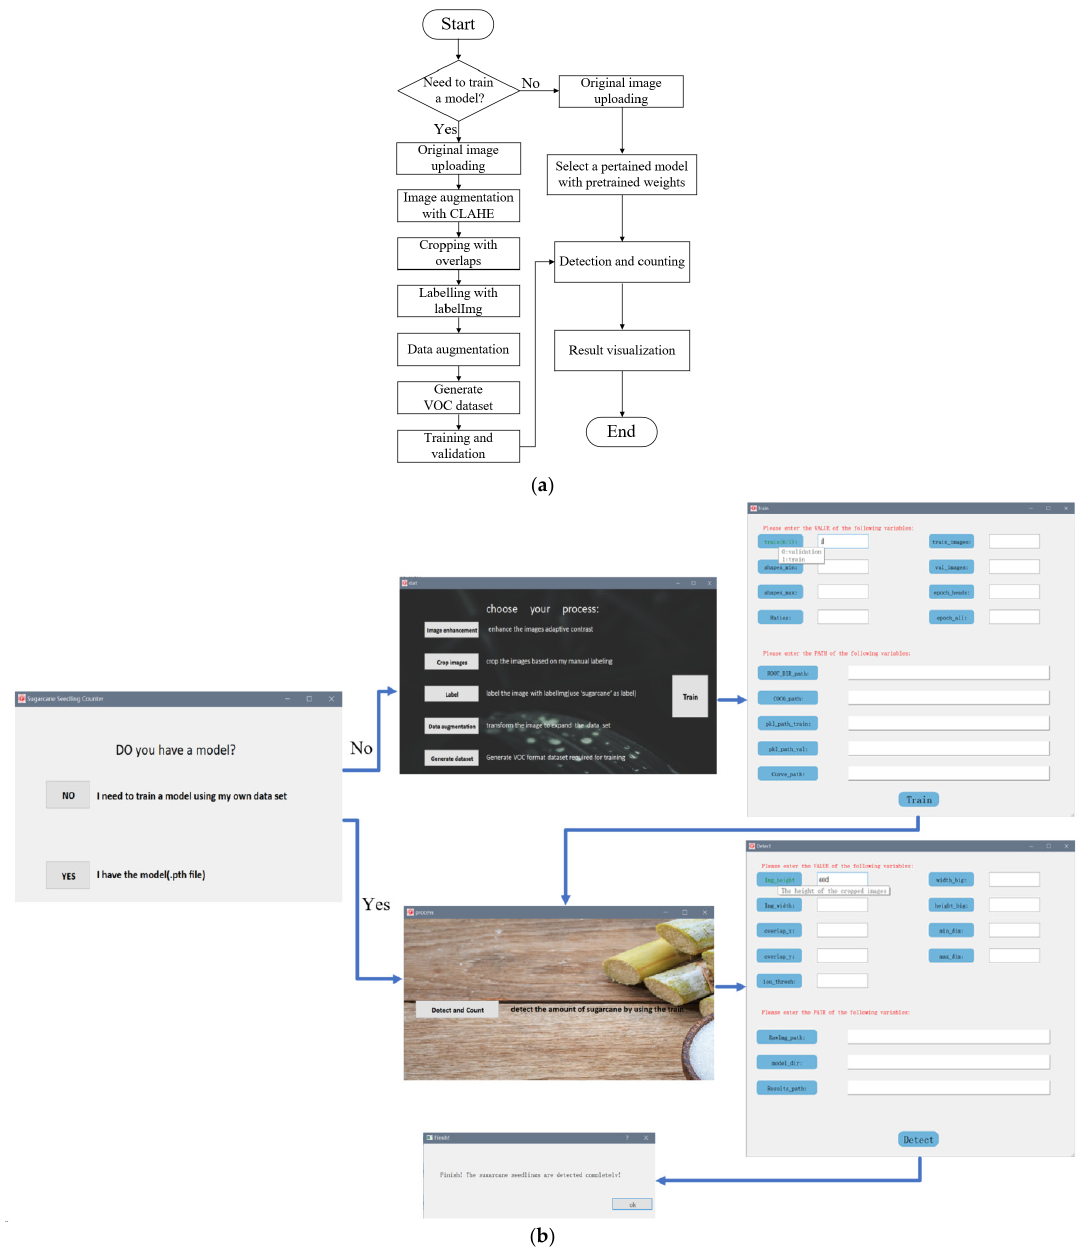
Figure 8 . ( a ) The flowchart of the software system. ( b ) The graphical user interface (GUI) allows users to choose to train their own models or use existing model.